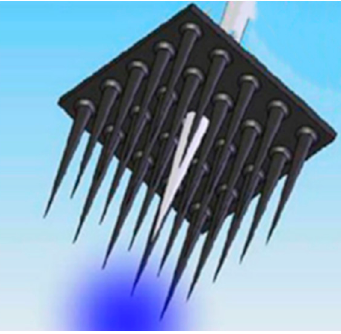
Figure 1. Example of a 3D microfabricated array made of glass.